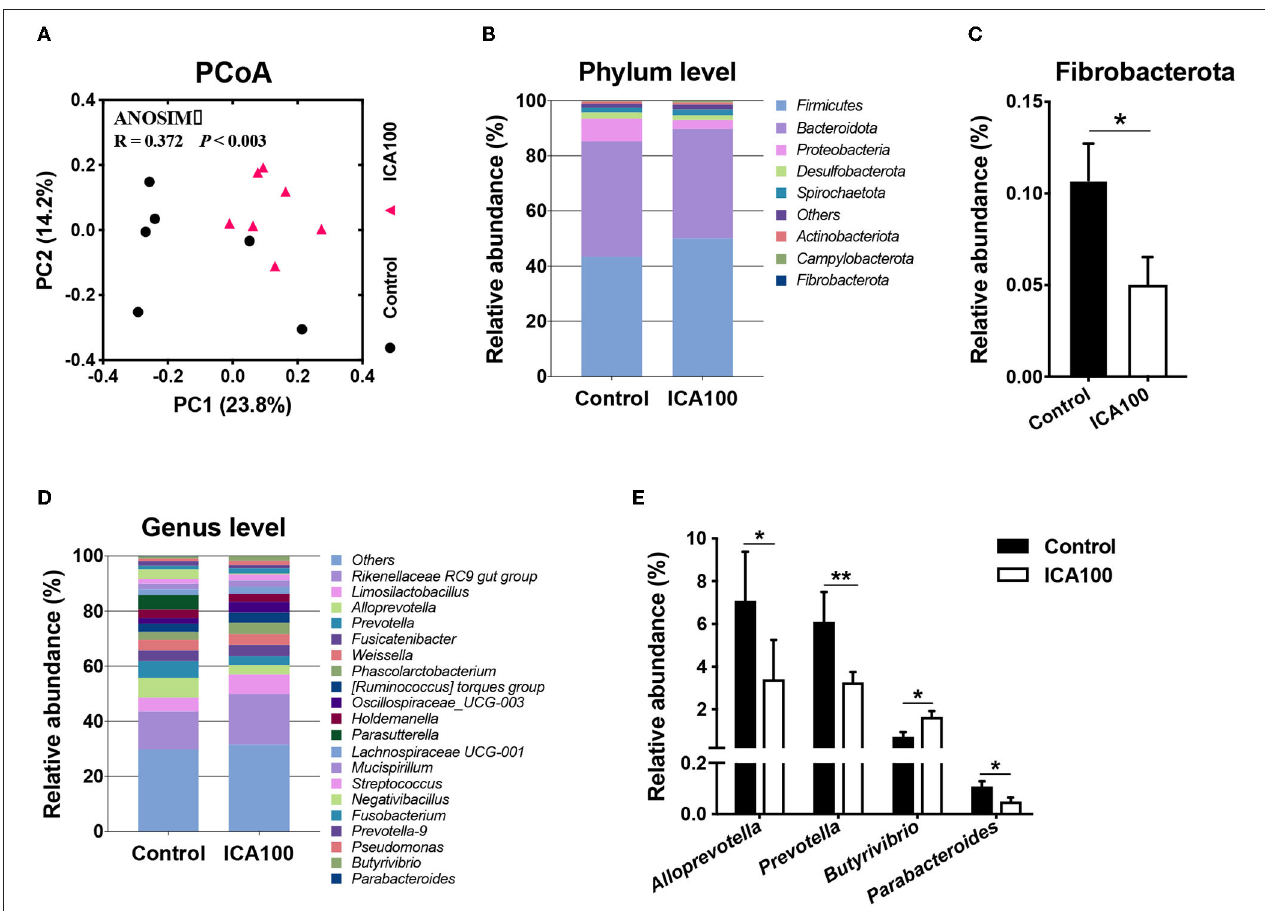
FIGURE 7 | Effects of dietary ICA supplementation on the colonic microbiota composition of weaned piglets. Principal coordinate analysis plot based on the Bray-Curtis index (A) . Relative abundance of reads at phylum-level (B) and significantly different phyla (C) . Relative abundance of reads at genus-level (D) and significantly different genera (E) . Data are expressed as medians. * P < 0.05, ** P < 0.01 vs. the Control group. ICA100, the basal diet supplemented with 100 mg/kg